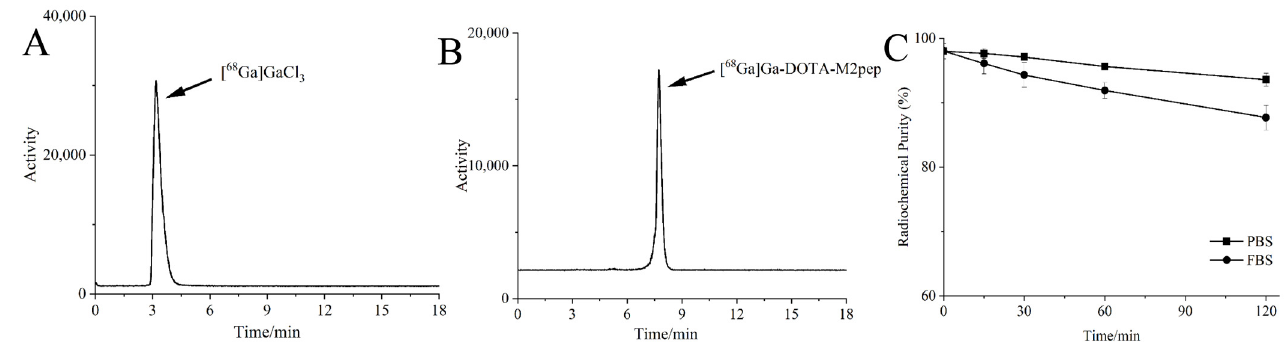
Figure 2. ( A ) Radio-HPLC of [ 68 Ga]GaCl 3 . ( B ) Radio-HPLC of [ 68 Ga]Ga-DOTA-M2pep, showing a radiochemical purity of over 95%. ( C ) Stability of [ 68 Ga]Ga-DOTA-M2pep in phosphate-buffered saline (PBS) and fetal bovine serum (FBS) over 2 h.